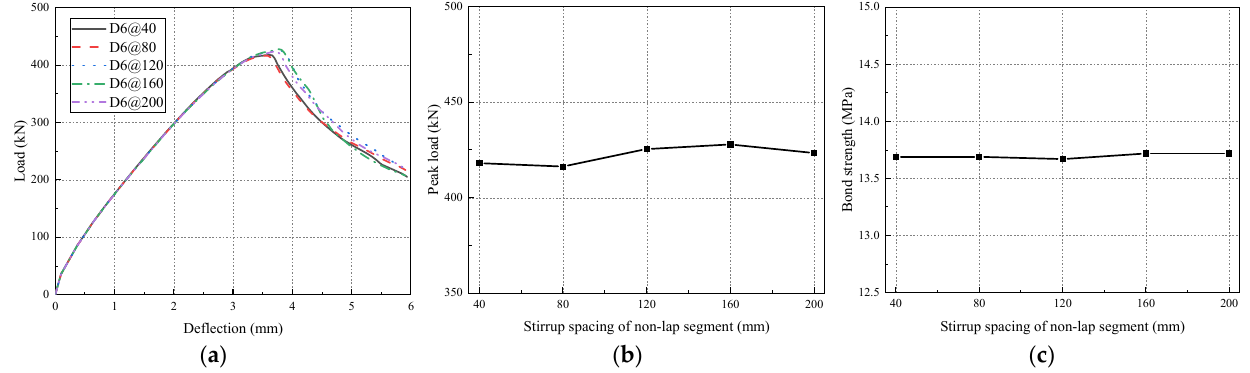
Figure 19. Influence of stirrup spacing of non ‐ lap segment: ( a ) load–deflection curve; ( b ) peak load; ( c ) bond strength.